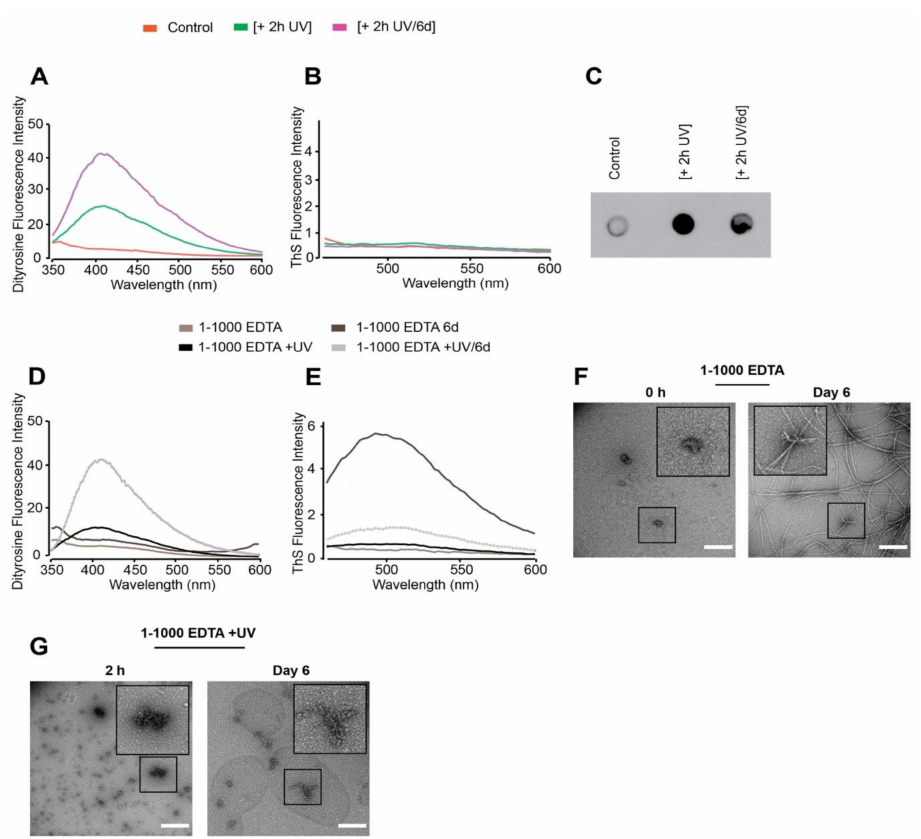
Figure 5. Freshly prepared dGAE samples (100 µ M) were incubated without UV (control) or in the presence of UV for 2 h at 4 ◦ C [+2 h UV], and the 2 h UV-exposed sample was further incubated for six days at 37 ◦ C/350 RPM [+2 h UV/6 d]. Measurement of DiY signal over time revealed the induction of DiY by the UV exposed sample ( A ). ThS fluorescence assay showed no fluorescence intensity indicating there was no assembly in any of the samples ( B ). Immunoblotting using the T22 antibody, suggested the presence of a large quantity of tau oligomers in the UV-exposed samples compared to control ( C ). Freshly prepared 1-1000 EDTA samples were incubated without UV for 2 h or 6 days at 37 ◦ C/350 RPM (1-1000 EDTA 6 d) and with UV for 2 h (1-1000 EDTA +UV) or 2 h UV followed by 6 days incubation at 37 ◦ C/350 RPM (1-1000 EDTA +UV/6 d). DiY signal was collected at each time point ( D ), followed by ThS fluorescence assay, which suggested assembly in the 1-1000 EDTA 6 d sample and not the others ( E ). TEM imaging at 0 h revealed small, round assemblies in the 0 h [1-1000 EDTA] sample, which assembled into long mature fibrils after 6 days incubation at 37 ◦ C/350 RPM ( F ). The 1-1000 EDTA + UV samples revealed both small and large clumped assemblies, which remained largely unchanged even after 6 days of incubation at 37 ◦ C/350